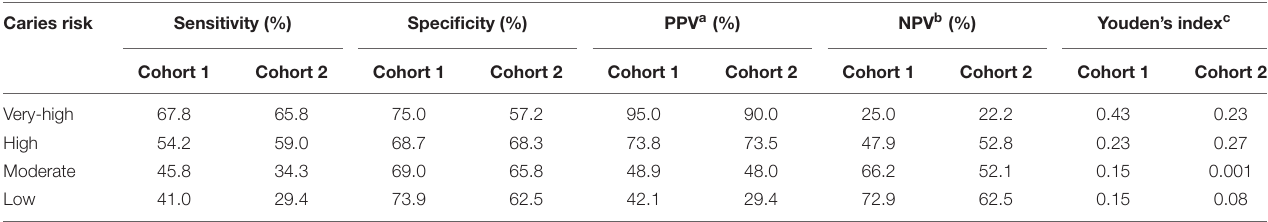
TABLE 6 | Sensitivity, specificity, and predictive values for new caries lesions over 21 months. Caries